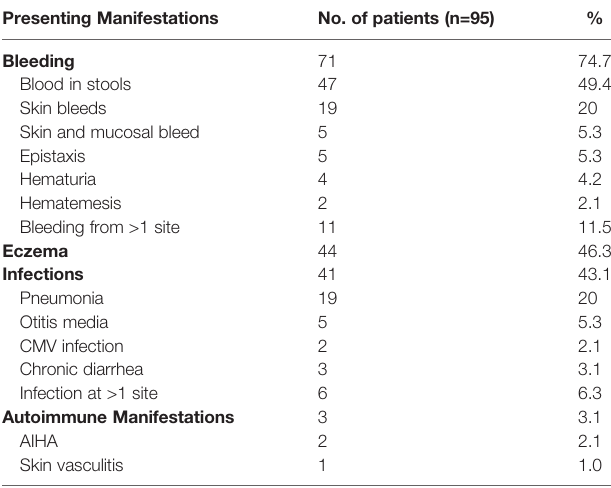
TABLE 2 | Clinical manifestations at the time of presentation in the